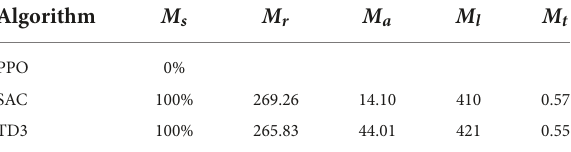
TABLE 2 Comparison of test data.